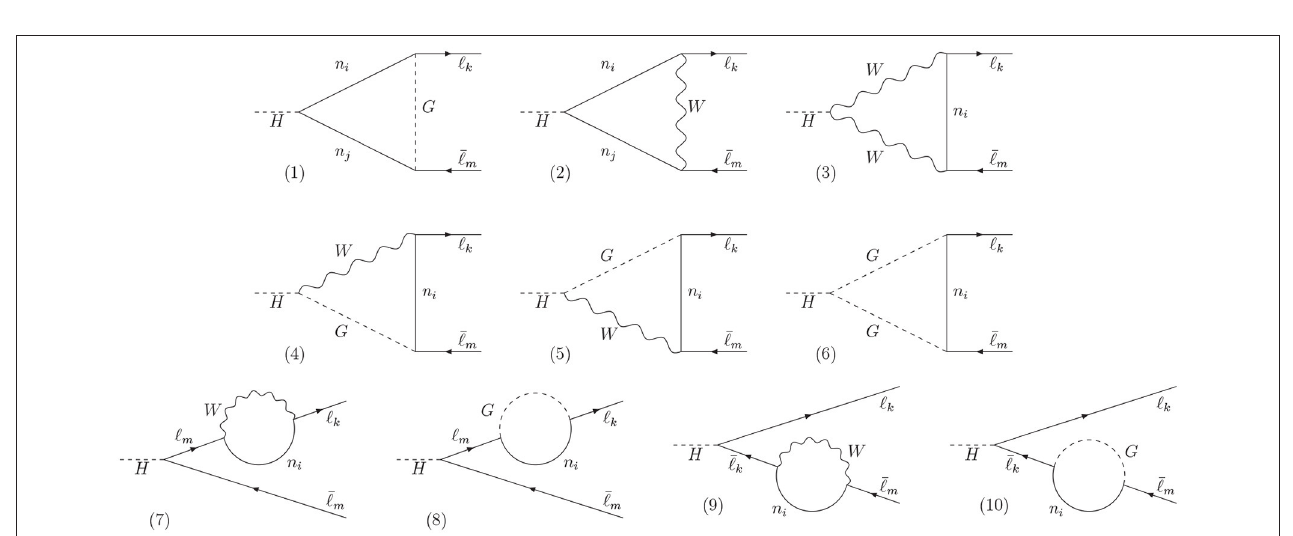
FIGURE 5 | One-loop diagrams in the Feynman-’t Hooft gauge for the process H